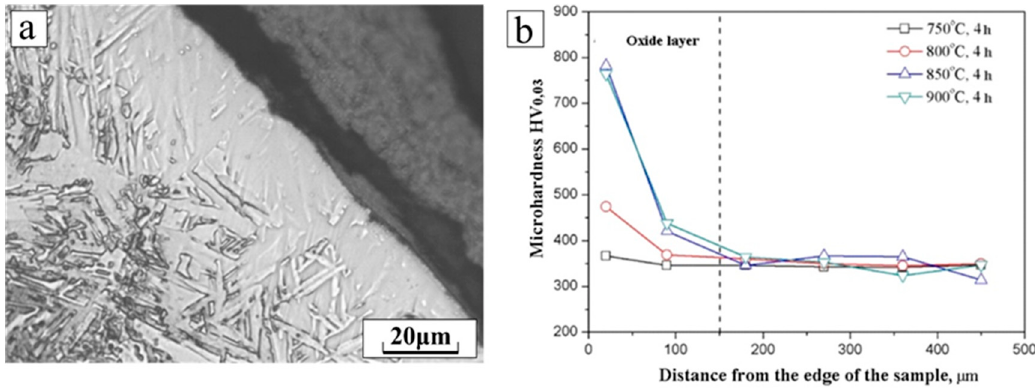
Figure 2. The formation of an oxide layer in deposited Ti-6Al-4V during heat treatment in an air atmosphere; ( a ) an oxide layer of Ti-6Al-4V after HT at 900 °C for 4 h; ( b ) the dependence of the oxide layer hardness of the holding temperature.